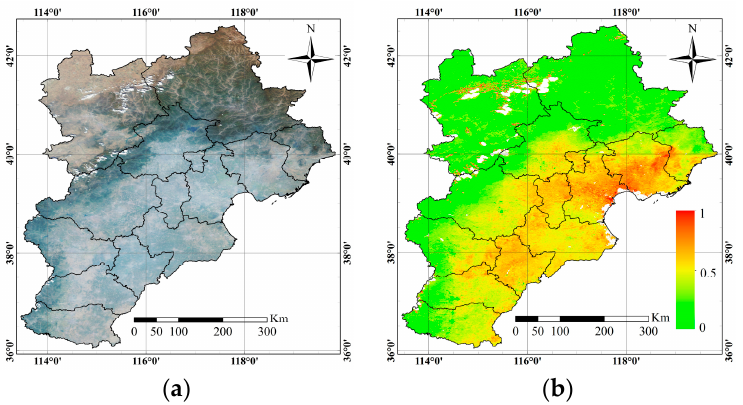
Figure 11. ( a ) Terra/MODIS true color image and ( b ) GF-1/WFV AOD_WORT AOD spatial distribution on 28 September 2019.